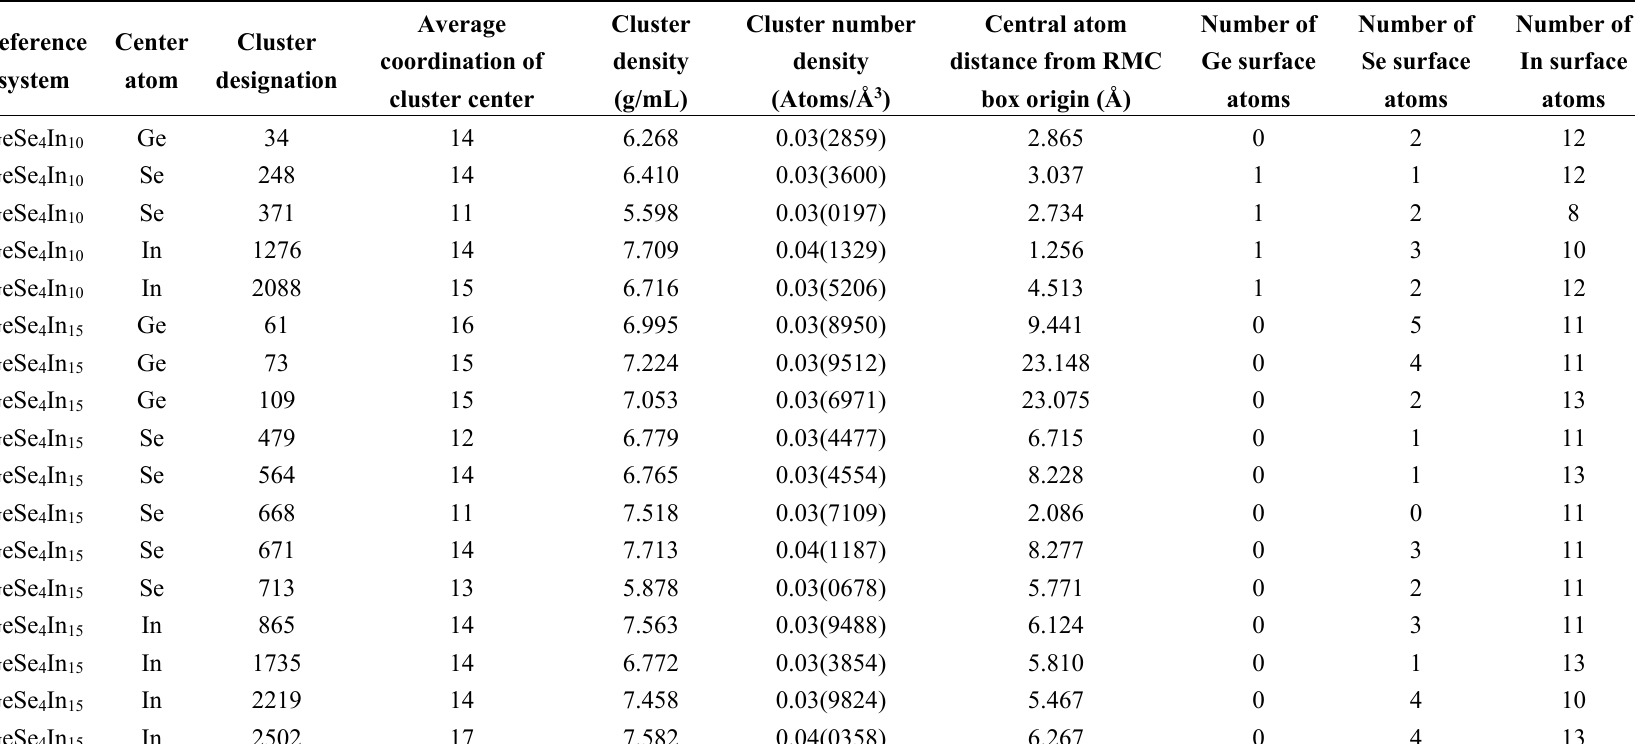
Table 3. A list of the most characteristic clusters of the GeSe 4 In 10 and GeSe 4 In 15 systems selected on the basis of the radial distributions of cluster center average coordination, cluster center coordination by the matrix species (Ge) and cluster number density. In the forthcoming discussion, cluster notation will be defined by mention of the reference system first (e.g., GeSe 4 In 10 ) followed by the center atom and the cluster designation, which is unique to the cluster (e.g., Ge 34 , hence the cluster corresponding to the first row of this table will be GeSe 4 In 10 -Ge 34